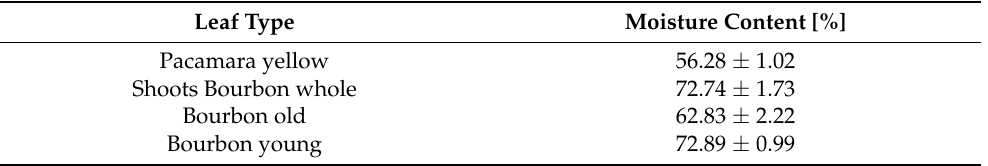
Table 3. Moisture content of the different coffee leaves directly after picking shown as mean ± standard deviation.